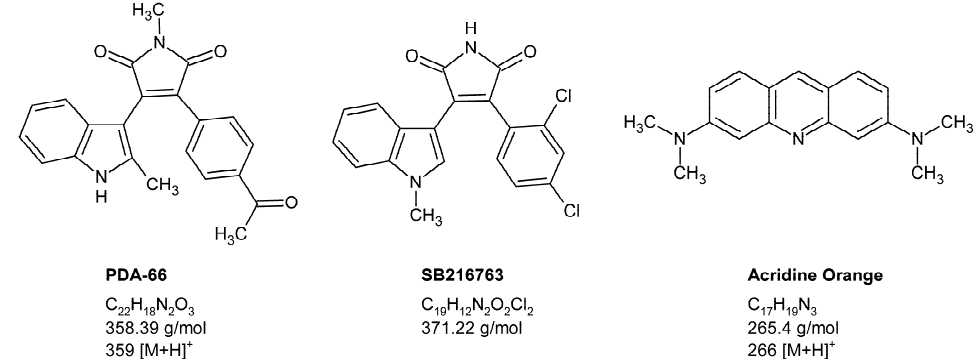
Figure 1. Chemical structures, molecular formulae and molecular weights of PDA-66, SB216763 and the internal standard acridine orange. In the case of PDA-66 and acridine orange, the precursor ions are also indicated.